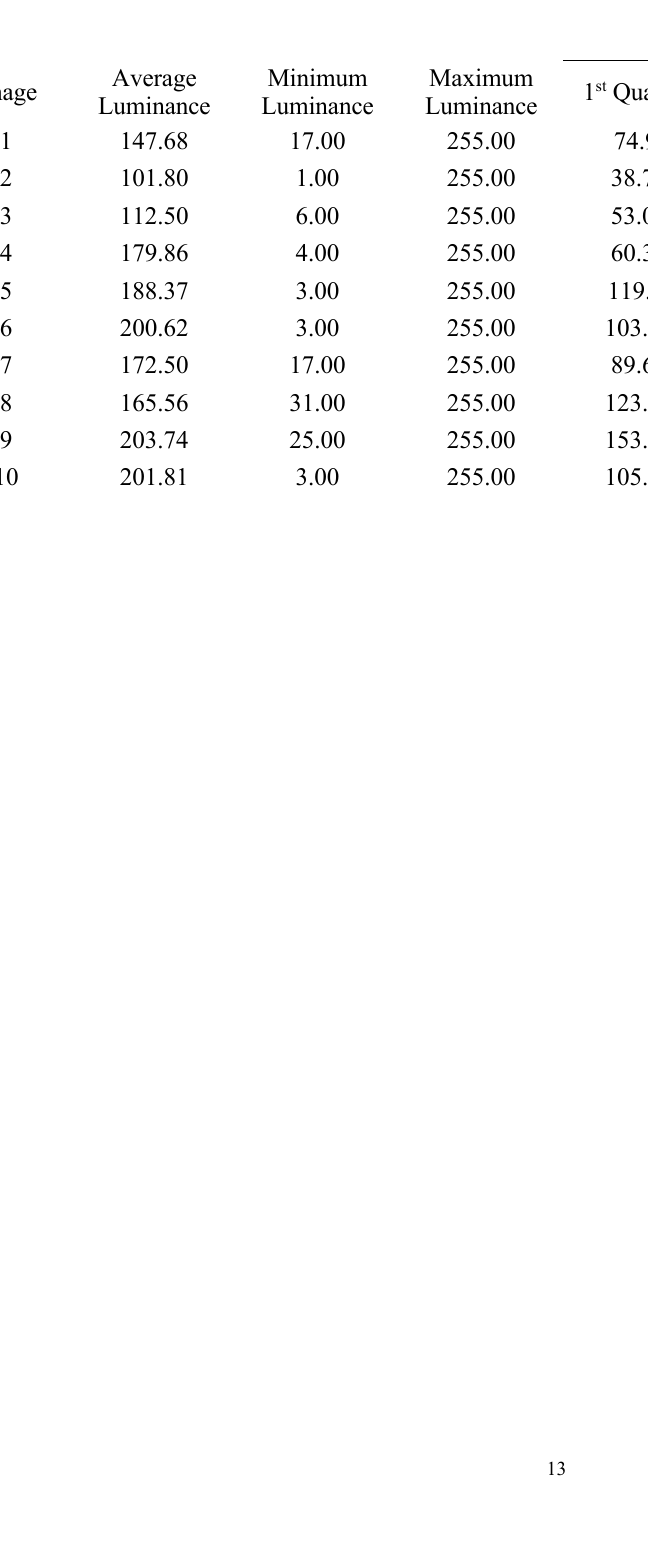
Table 1: Luminance information on images used during picture difference